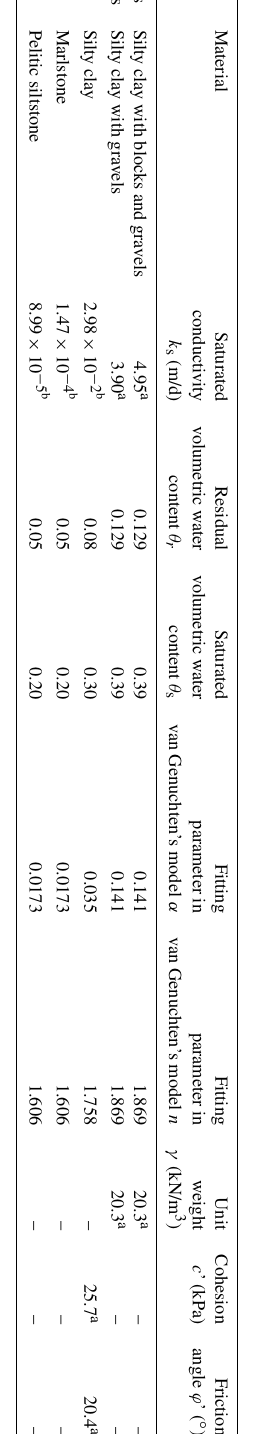
Figure 16. Simulated groundwater tables over the period of gen- eralized annual variation in reservoir water level in Stage 3. Gray shaded zone depicts the 145 to 175m elevation interval. (a) Slow- drawdown phase, (b) rapid-drawdown phase, (c) low-level phase, (d) water-level-rising phase, (e) high-water-level phase.